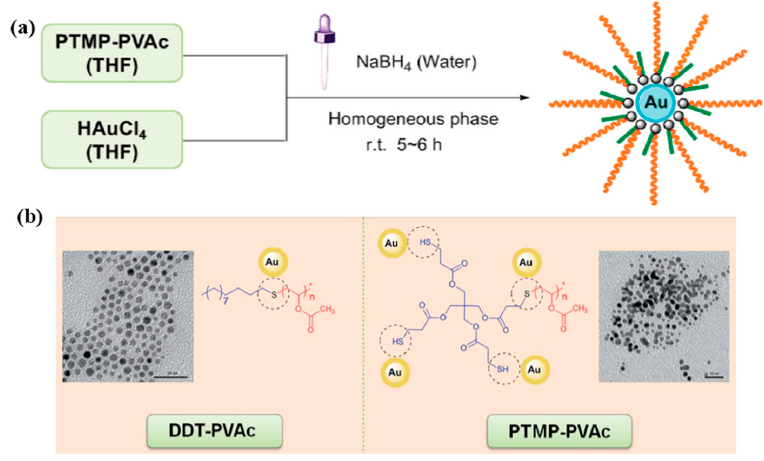
AuNCs capped by thioether end-functionalized ligands. The scale bar is 20